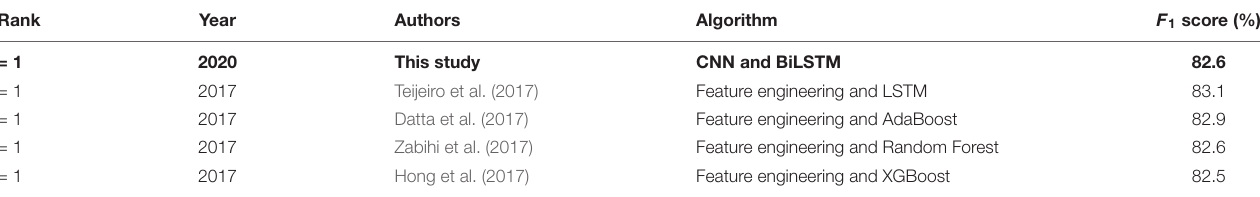
TABLE 3 | Performance comparison between the proposed deep learning model in this study and previously tested algorithms on the PhysioNet Challenge 2017 dataset (Goldberger et al.,